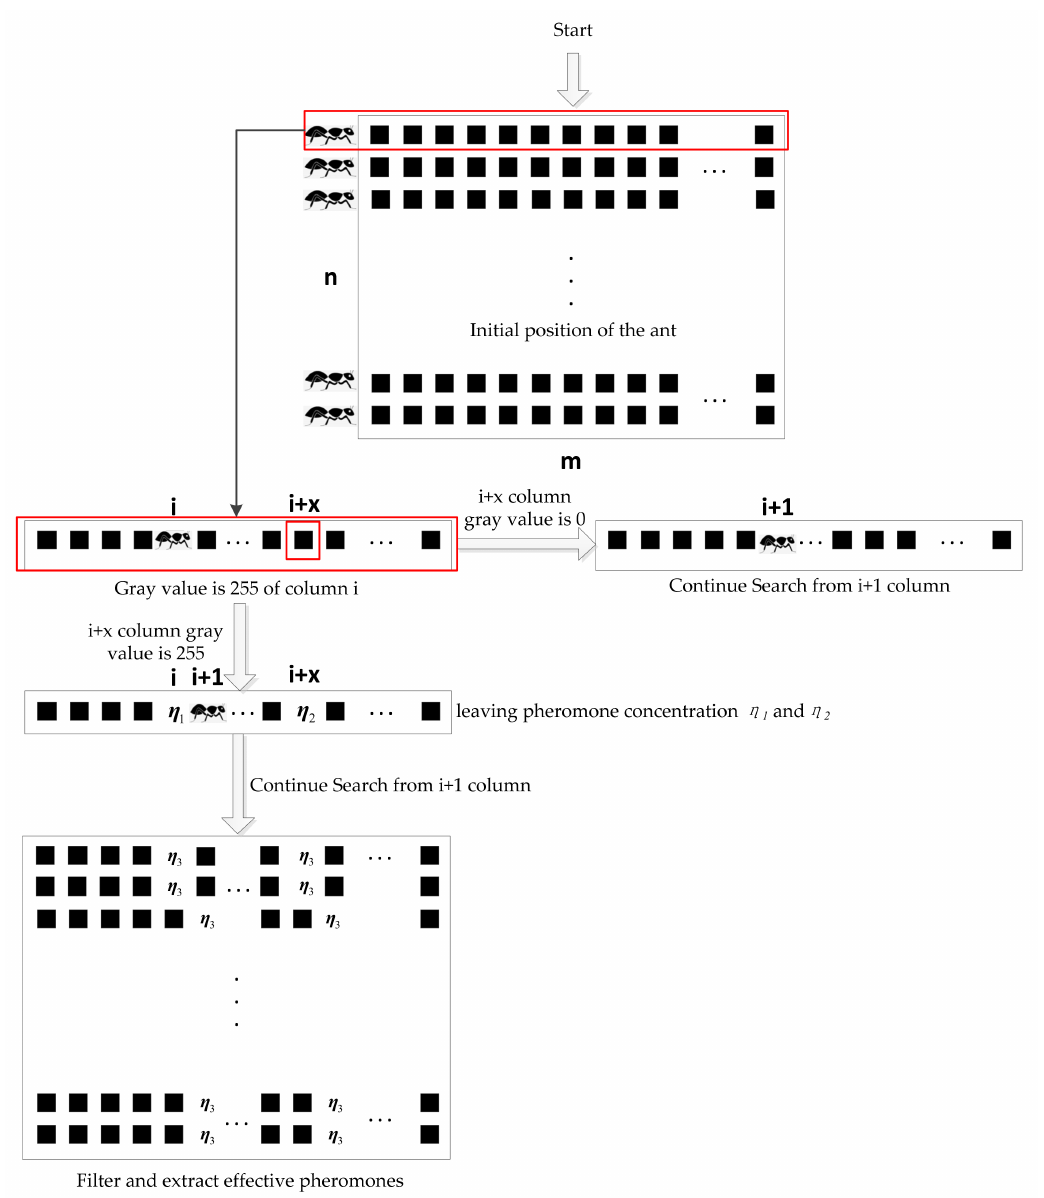
Figure 3. Flowchart of lead extraction based on ant-like algorithm. The above algorithm is only a preliminary, rough extraction of all lines including the edge of the guide wire; when there are messy lines on the ground with a width similar to the guide wire, relying only on the above algorithm cannot ensure that only the guide wire is accurately extracted and other interference lines can be eliminated. Therefore, based on the above algorithm, this paper carries out secondary screening of guide wires, i.e., by limiting the contour area to a specific range to get rid of the line interference, similar to guide wires. The specific steps are as follows: determine the upper and lower limits of y -axis coordinates in combination with the preview distance in all the obtained edges, take this range as the two horizontal edges of the contour area, take the edge lines preliminarily extracted by the ant colony-like algorithm in the previous step as the two vertical edges of the contour, and then filter according to the contour area. Firstly, the library “numpy” is used to count the number of contour areas, and then the OpenCV library is used to calculate the area of each area extracted by the ant colony-like algorithm. Only the contour with